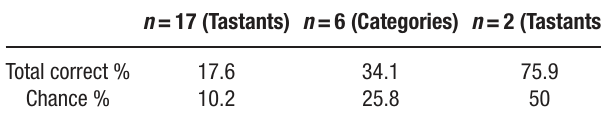
Table 1 . Prediction strength as a function of stimulus number, n